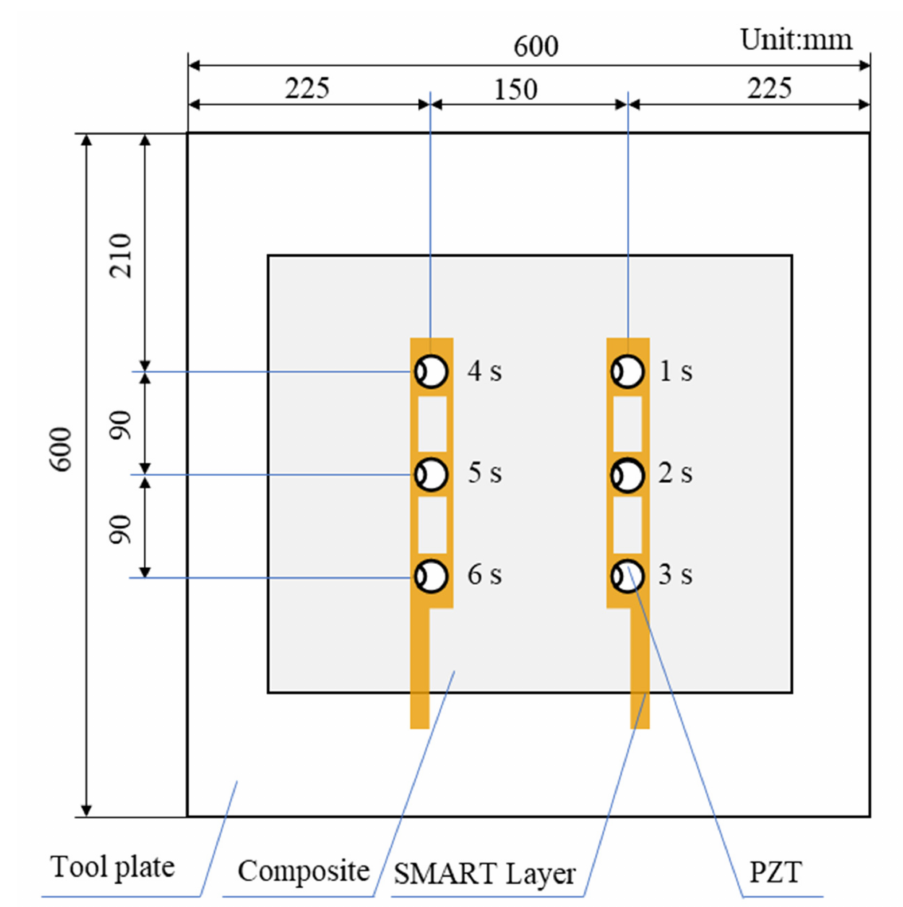
Figure 10. The schematic diagram of the fabricated specimen with layup [0/45/90/ − 45] 2s .